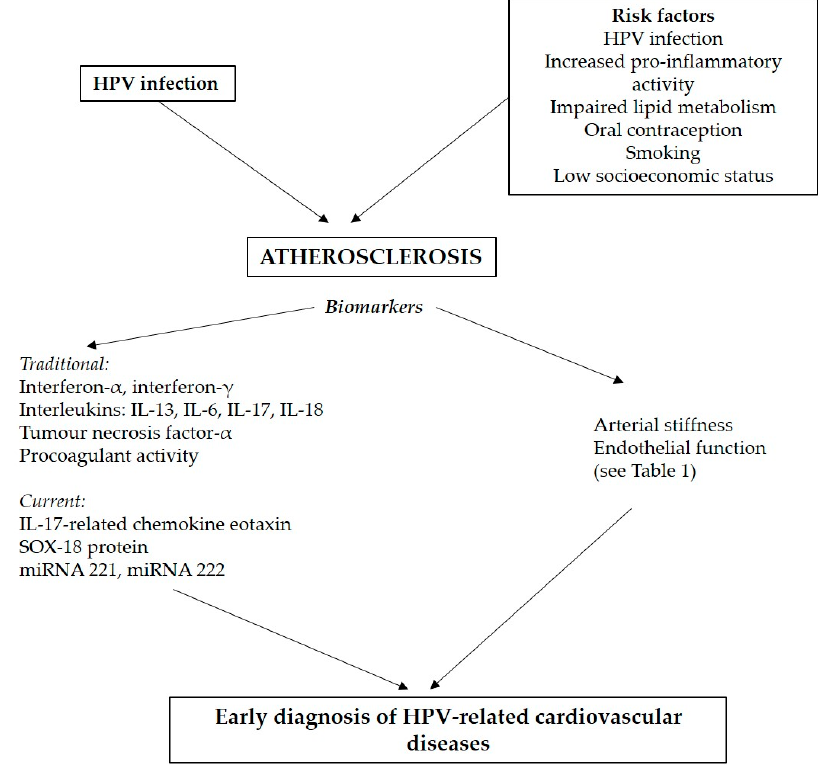
Schematic diagram of atherosclerosis-linked different risk factors and biomarkers HPV—Human Papilloma Virus; SOX-18 protein—SRY-related HMG-box 18, miRNA—microRNA.